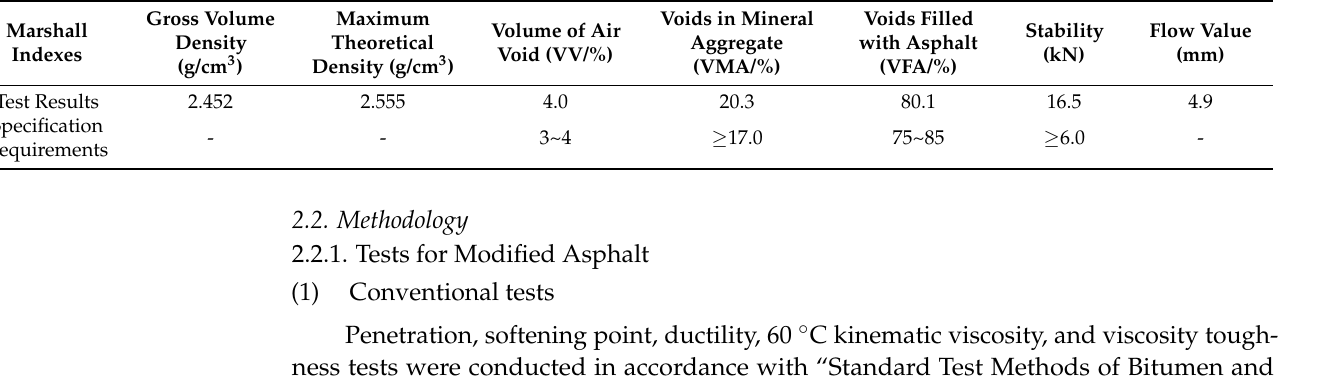
Table 4. SMA-10 Marshall specimen test